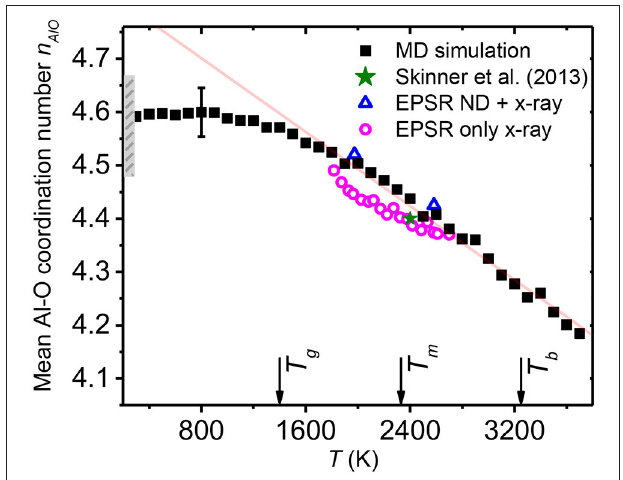
FIGURE 8 | Temperature dependence of the average Al-O coordination numbers obtained from the MD and EPSR models with a cutoff distance r 2 = 2.5 Å. The range of Al-O coordination numbers of amorphous alumina obtained from EPSR models at 300K are plotted as a gray bar, with densities ranging from 2.99 to 3.22g cm − 3 . The arrows indicate the model glass transition temperature T g = 1,395K and the experimental melting and boiling points, T m = 2,327K and T b = 3,250K, respectively.